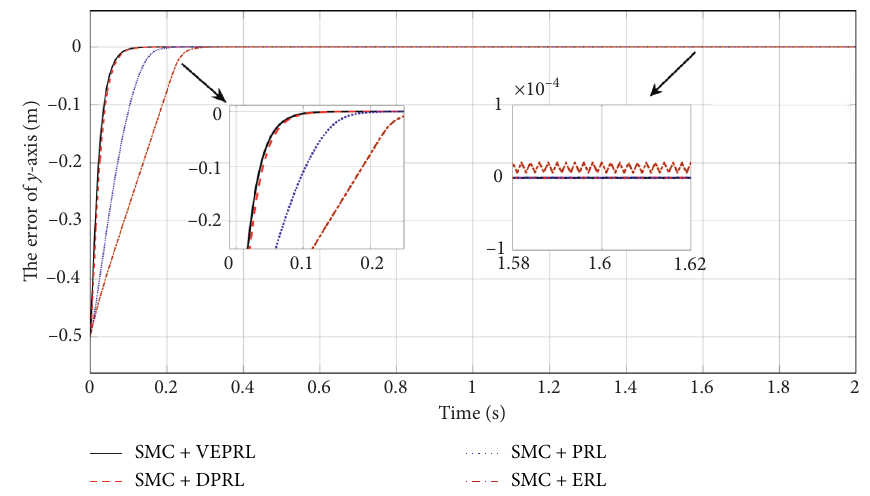
Figure 4: Comparison of y -axis tracking error of the ball and plate system under SMC.